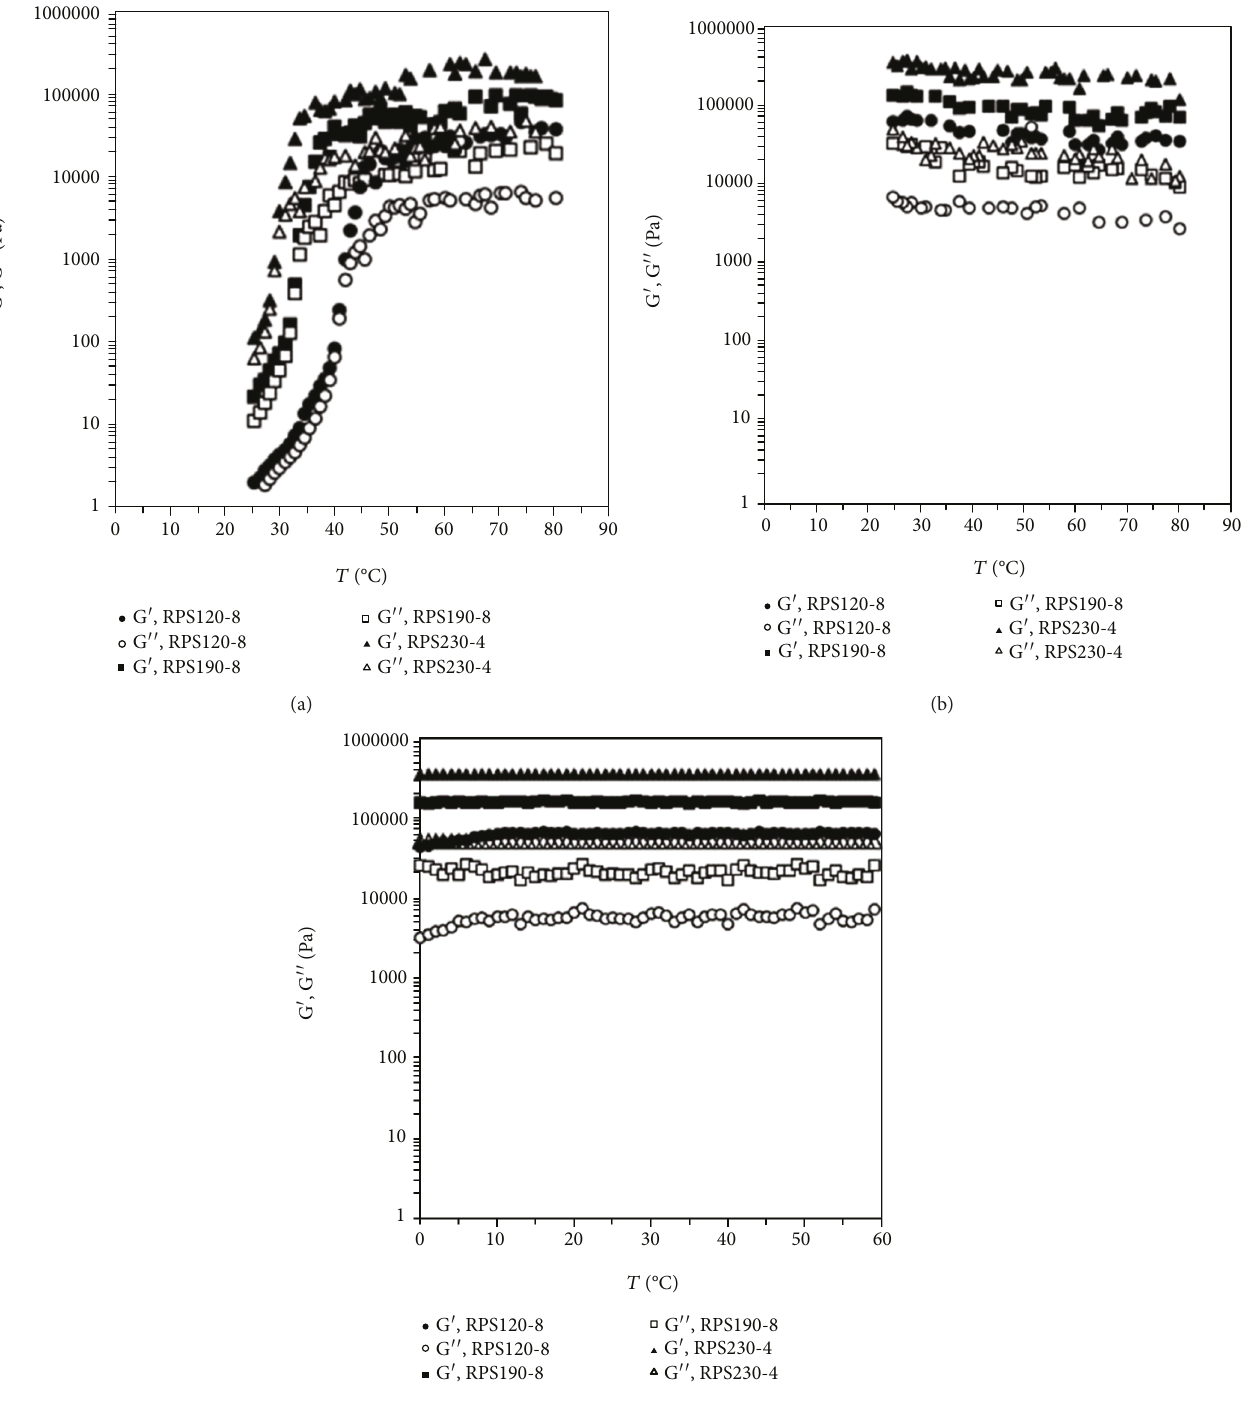
Figure 2: Thermorheological features of aqueous dispersions of potato starch (30% w / w ) roasted at 120 ° C for 8h (RPS120-8), 190 ° C for 8h (RPS190-8), and 230 ° C for 4h (RPS230-4): (a) temperature sweep on heating (from 25 to 80 ° C at 1 ° C/min); (b) temperature sweep on cooling (from 80 to 25 ° C at 1 ° C/min); and (c) time sweep (at 25 °